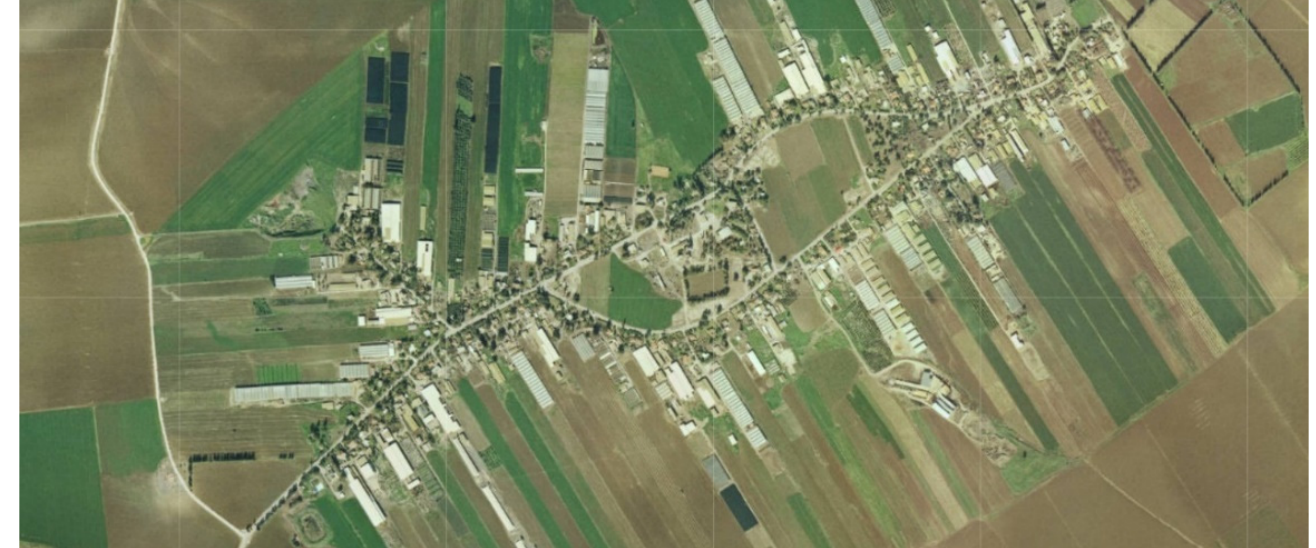
Figure 2. Aerial photograph of HaYogev, 2007. The moshav is elongated, broadening at the center. The agricultural plots stretch outwards, behind the houses. Source: Govmap.